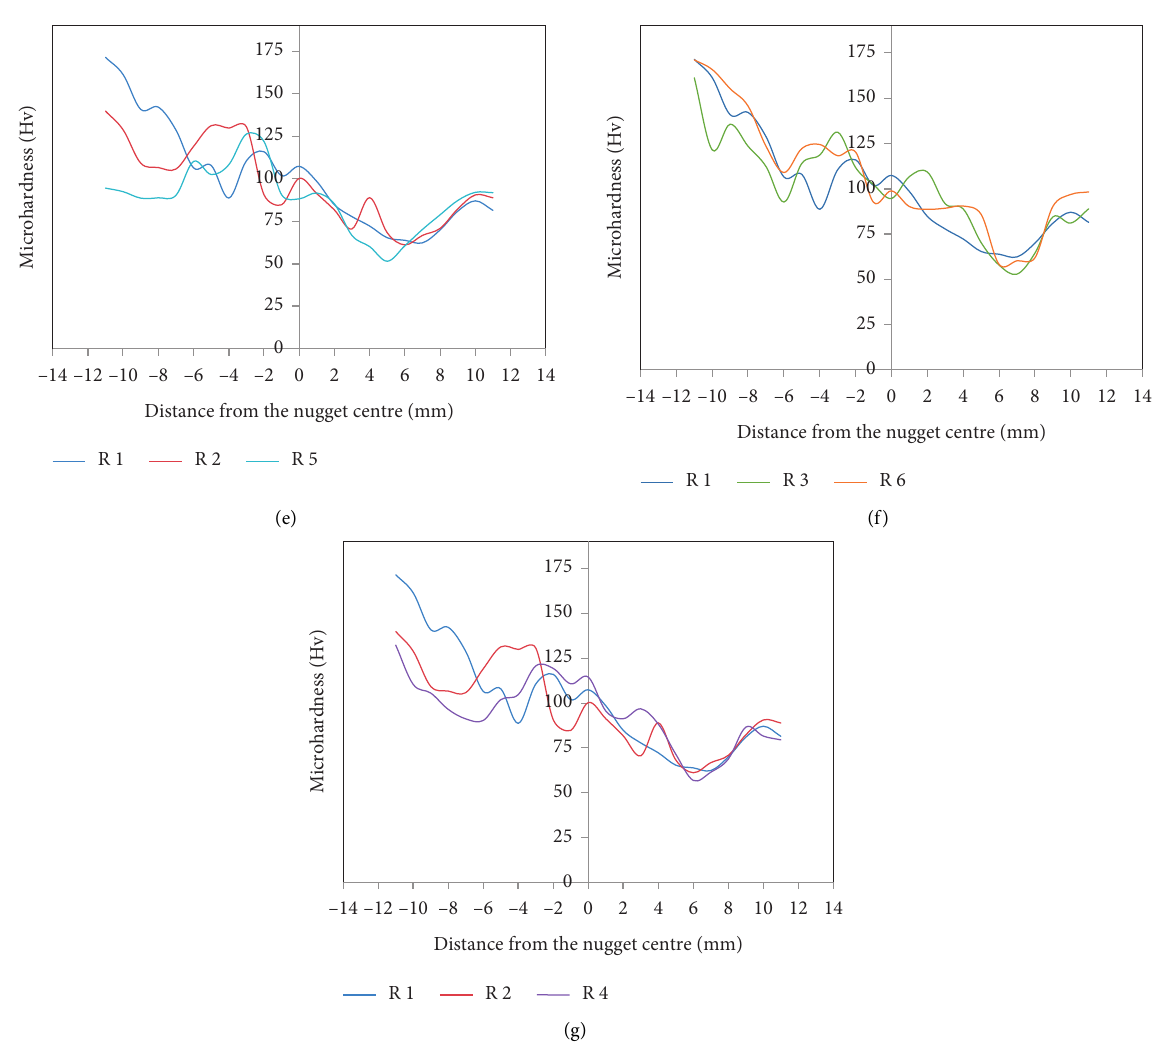
Figure 16: (a) Microhardness survey location and hardness survey of (b–d) composite welds and (e–g) welds without